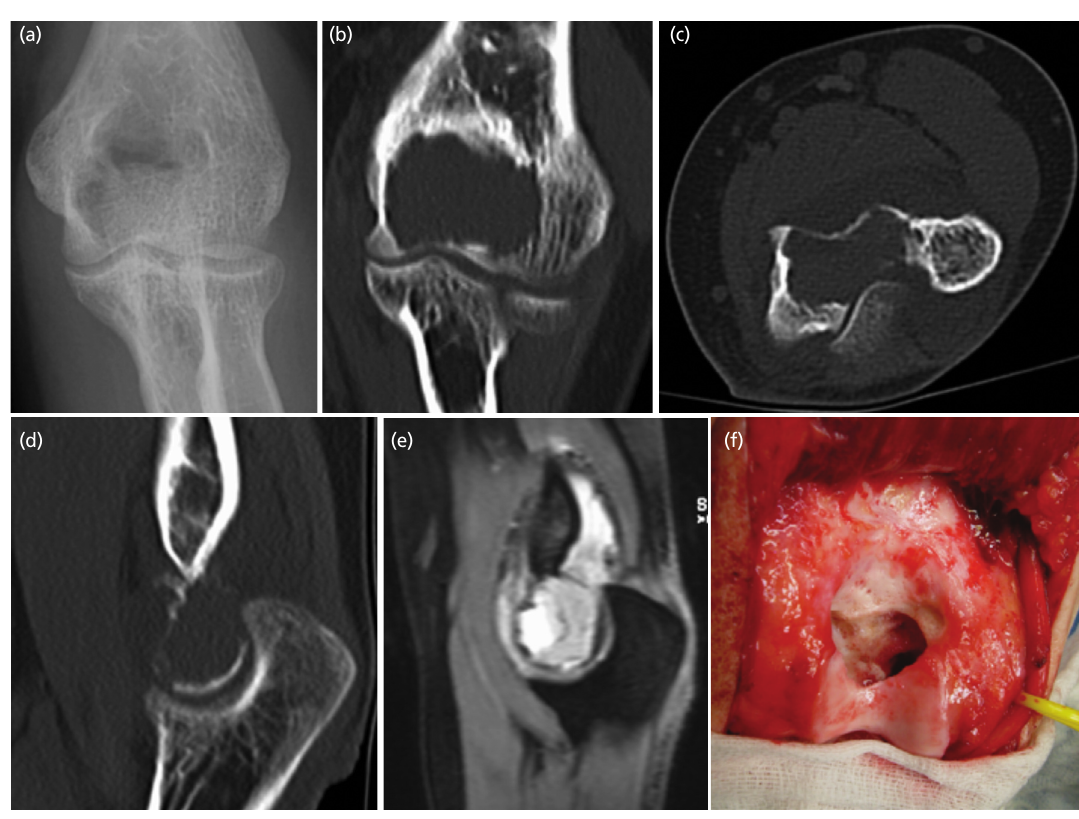
Fig. 1: Pre- and intra-operative images revealing the big lytic lesion in the epiphysis of the left elbow: (a) anteroposterior radiograph, (b) coronal, (c) axial and (d) sagittal CT-images, (e) sagittal MRI, and (f) posterior view after intralesional curettage and high- speed burring. The subchondral bone of the trochlea and the medial epicondyle was severely thinned out and posteriorly disrupted. The ulnar nerve was marked with a vessel loop.